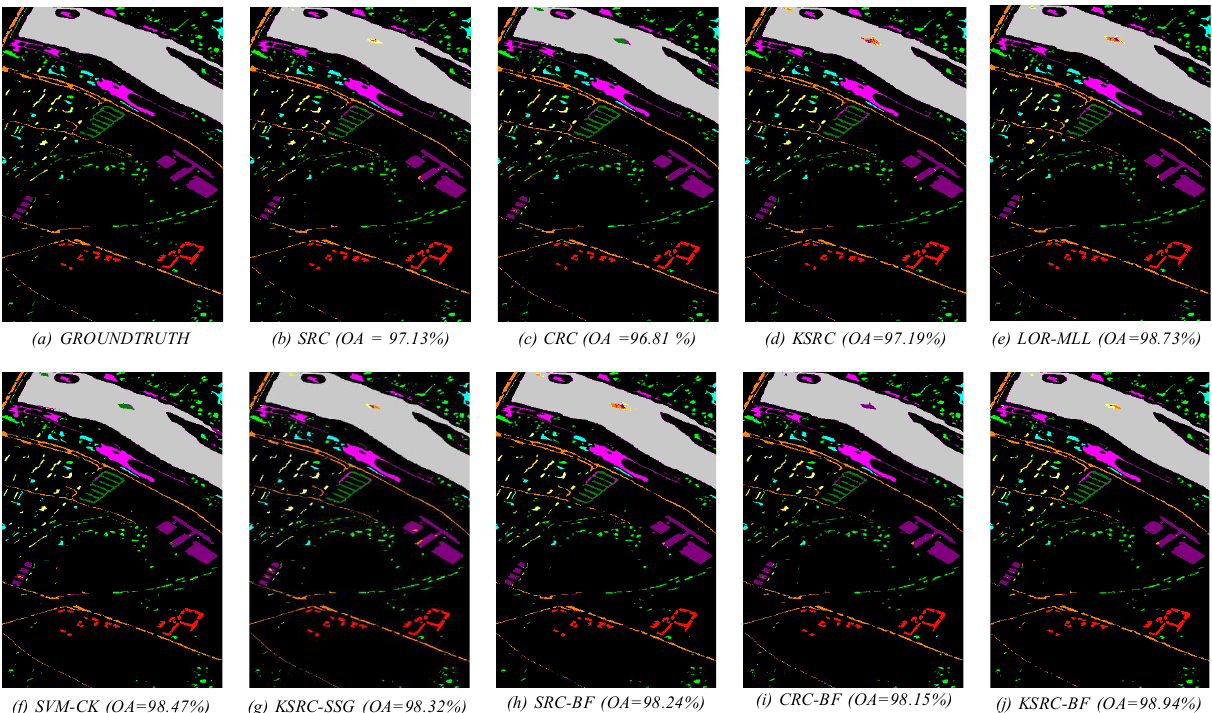
FIG. 4. CENTER OF PAVIA IMAGE. GROUND-TRUTH AND THE OVERALL ACCURACY OF THE METHODS WITH ABOUT 5% LABELED